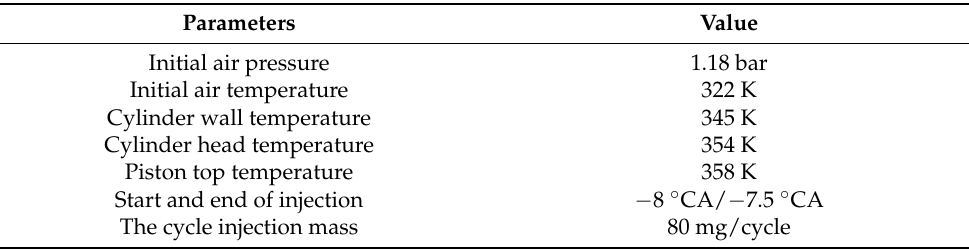
Table 2. The initial and boundary conditions of the simulated engine operating condition from GT-SUITE.